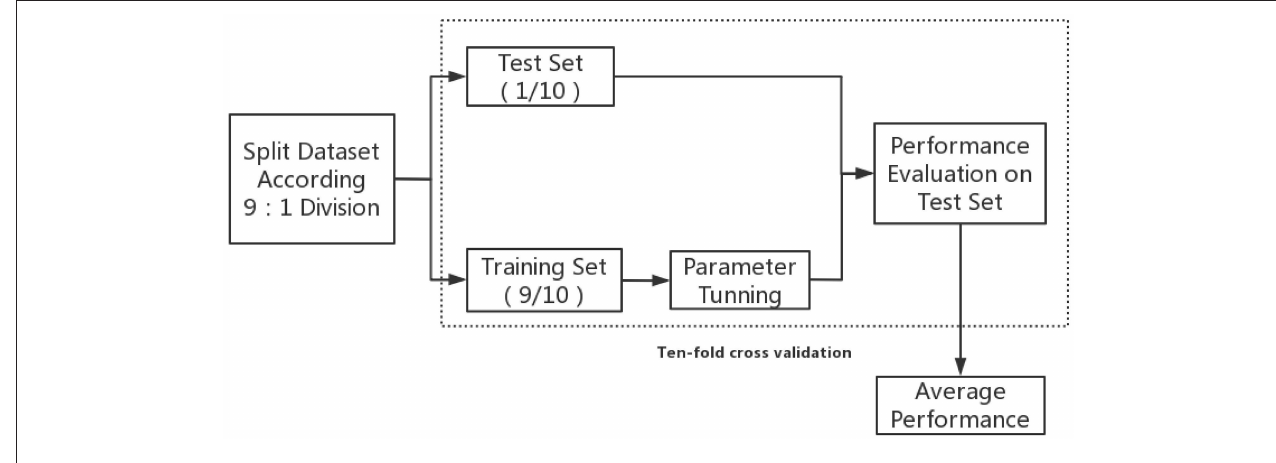
FIGURE 1 | Training and evaluation procedures of machine learning model.